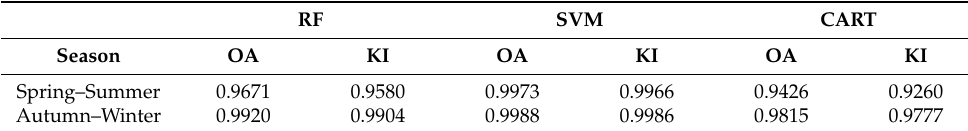
Table 5. Overall accuracy (OA) and Kappa index (KI) of the